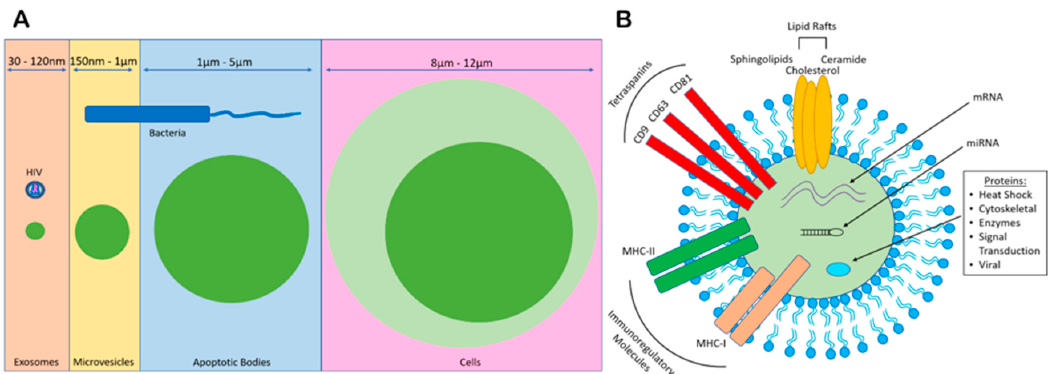
Figure 1. Size ranges of EVs and characterization. ( A ) Exosomes released when MVBs fuse with the PM are vesicles that range from 30–120 nm in diameter. Due to the similarity in size to viruses, exosomes are difficult to isolate from virus-infected blood. Microvesicles ranging from 150 nm–1 µm in diameter derive via shedding/budding from the PM surface. Apoptotic vesicles released from apoptotic cells range from 1 µm–5 µm in diameter. ( B ) Exosomes transport a variety of proteins and genetic material. Lipid raft-derived microdomains form larger domains responsible for inducing budding in an ESCRT-independent pathway of lateral cargo segregation. Exosomes are highly enriched with tetraspanins, which play a critical role in the ESCRT-independent pathway of endosomal sorting and function as exosome-defining surface markers. Depending on the cell of origin, exosomes may contain differing immunoregulatory molecules, such as MHC-I/II. Lastly, exosomes traffic a variety of host cell/viral protein, mRNA, and miRNA.